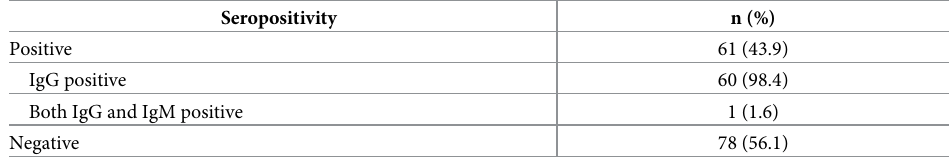
Table 1. Seropositivity of Toxoplasma gondii among slaughterhouse workers.